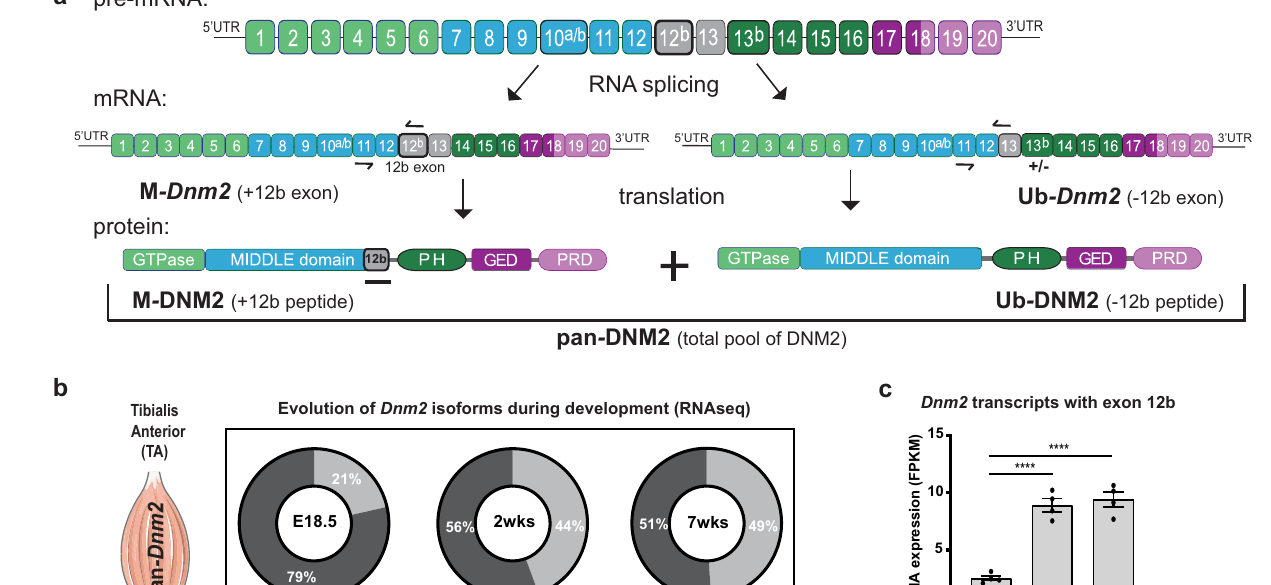
**** P <0.0001 by one-way ANOVA with Tukey ’ s post hoc test). d mRNA relative expression of M- Dnm2 done by RT-qPCR in several muscle and non-muscle tissues from 5-week-old wild-type mice ( n =3 mice). Level of expression in different tissues was compared to expression in TA for each mouse. e Representative western blot with protein extracts from 5-week-old wild-type mouse tissues ( n =3 mice) probed with DNM2 pan-isoform antibody and M-DNM2 antibody (against 12b peptide). Right,foldincreaseofpan-DNM2andM-DNM2proteinlevelcomparedtoTAlevelin each mouse ( n =3 mice). c – e Data are represented as mean values±SEM. Source data are provided as a Source Data fi